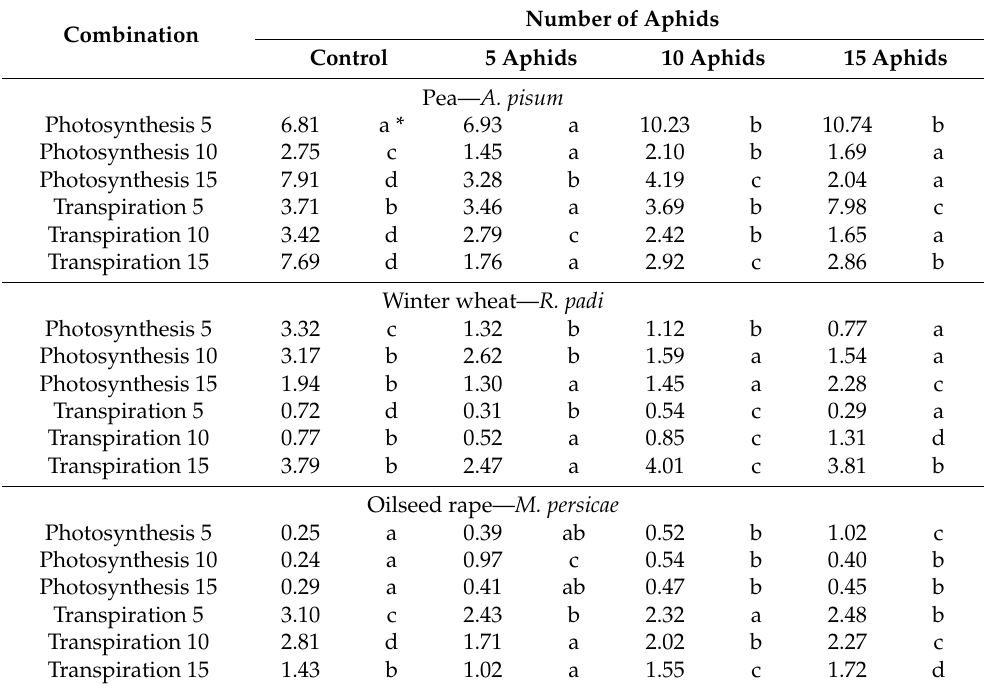
Table 3. Mean values of the parameters of photosynthesis and transpiration in the test plants during the foraging by aphids.